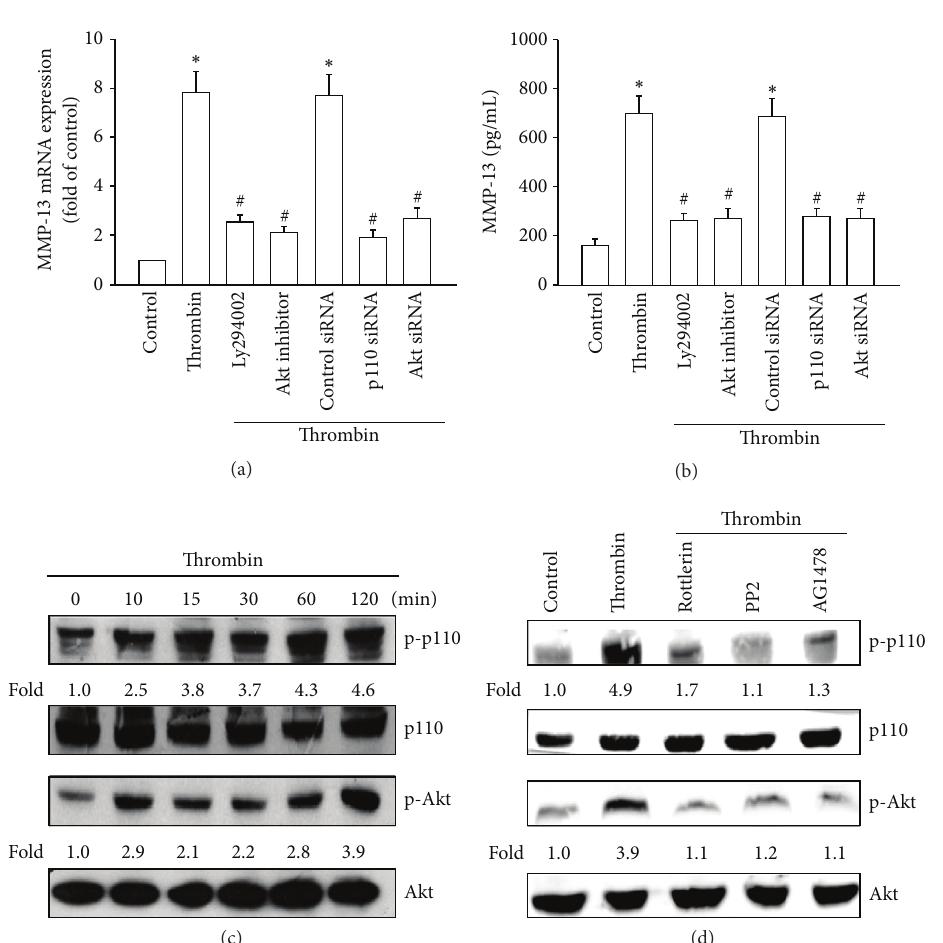
Figure 5: Involvement of EGFR transactivation and subsequent PI3K/Akt activation in thrombin-induced MMP-13 expression. ((a) and (b)) qPCR and ELISA analyses of MMP-13 expression in chondrocytes, which were pretreated with Ly294002 or the Akt inhibitor for 30min or transfected with siRNAs against p110 or Akt for 24h and then stimulated with thrombin for 24 h. (c) Western blotting analyses of p110 and Akt phosphorylation in cells incubated with thrombin for the indicated time intervals. (d) Western blotting analyses of p110 and Akt phosphorylation in chondrocytes pretreated with rottlerin, PP2, or AG1478 for 30min and then stimulated with thrombin for 60min. ∗ 𝑃 < 0.05 as compared with basal levels. # 𝑃 < 0.05 as compared with the levels in the thrombin-treated